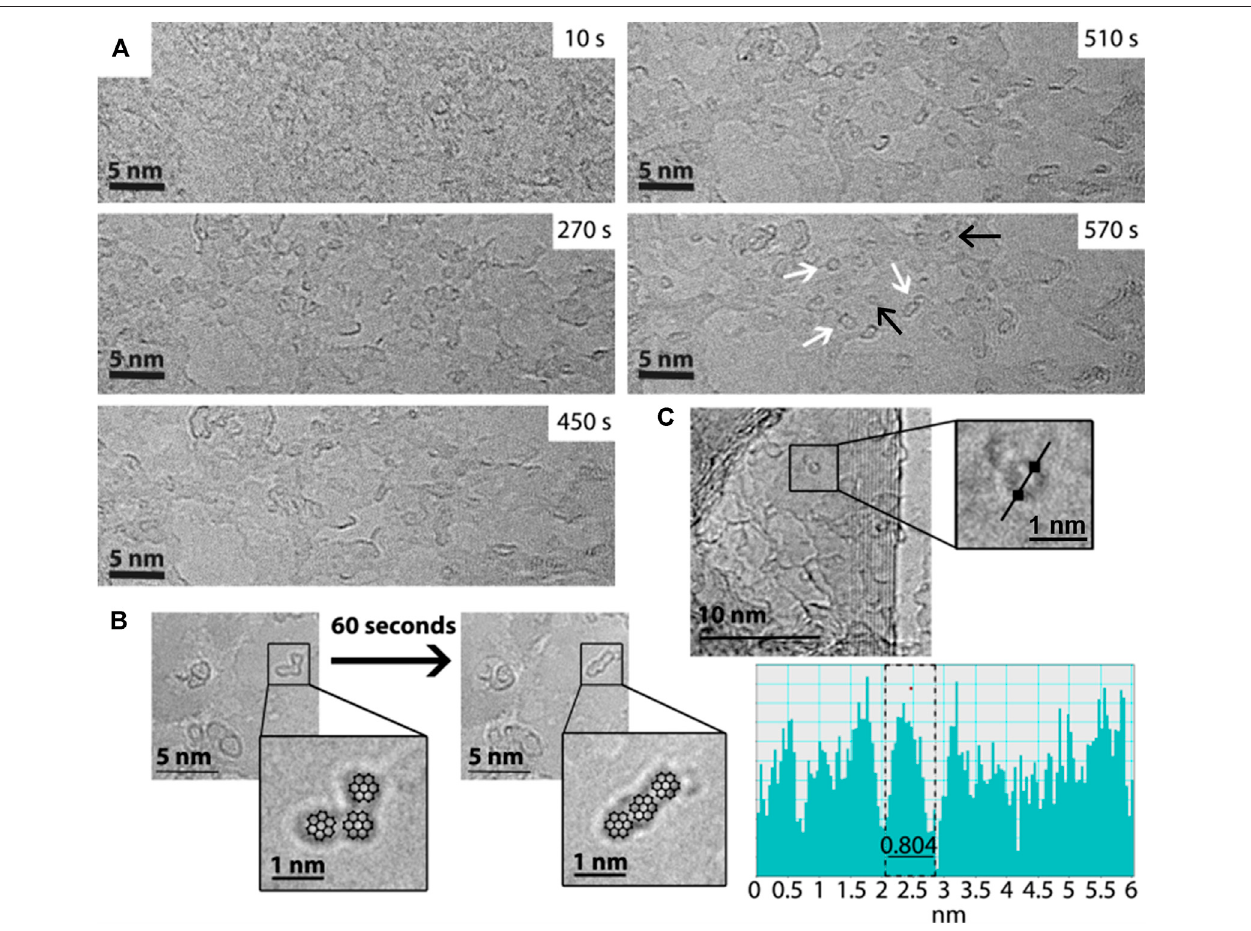
FIGURE1|(A) HRTEMtimeseriesofimagesshowingthetransformationfromaspatiallyunde fi nedstartingsampleofperylene(at10 s)towell-de fi ned “ islands ” or oligomers(570 s)andfullerenestructuresadsorbedonsurfaceofgraphitesupport. Whitearrowsindicate examplesofnewlyformed, stableoligomersandblackarrows show fullerenestructures. (B) HRTEM images showingthe evolution ofPAH oligomers,resultingfrom theirradiation ofcoronene over atime period of ∼ 60 s.Asaguide; coronene structures are overlaid the micrographs in the zoomed-in inserts. (C) HRTEM showing an example of fullerene structure (see zoomed-in region), formed as a result of prolonged irradiation of coronene, alongside a line pro fi le plot showing the structure to have a diameter comparable to C 60 (0.8 ± 0.1 nm).